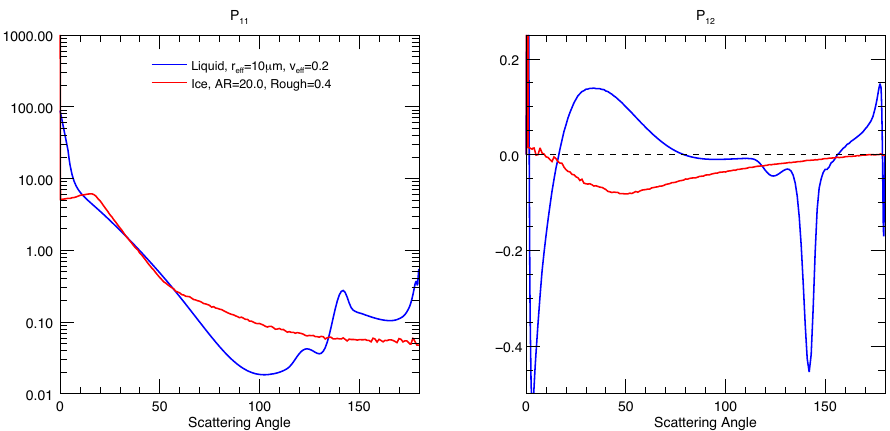
Figure 3. Example P 11 and P 12 phase matrix elements for water (blue) and ice (red) clouds. The P 11 element, which generates scattering from unpolarized radiation for the I Stokes vector component, is quite similar for water and ice clouds at typical scattering angles for ground observation (less than 70 ◦ ). Conversely, the P 12 element, which generates scattering from unpolarized radiation for the Q Stokes vector component, has a different sign for most observable scattering angles. As we have seen in Fig. 2, this sign difference is maintained with multiple scattering. Note that both P 11 and P 12 are strongly forward-scattering, but that this peak is beyond the plotting range for P 12